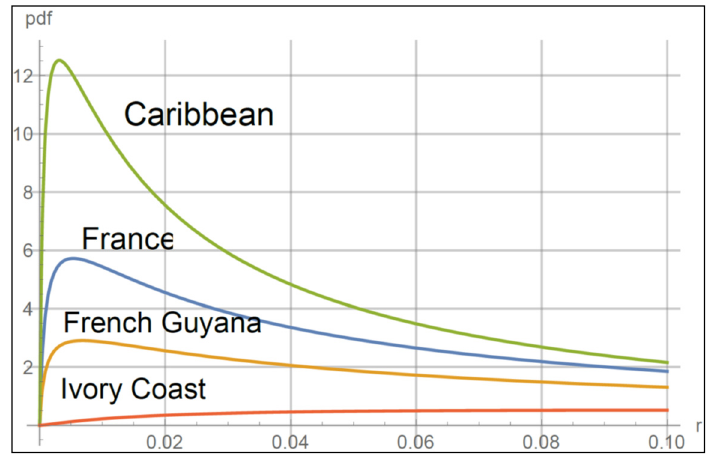
Figure 1. Lognormal distribution for values of parameters in Table